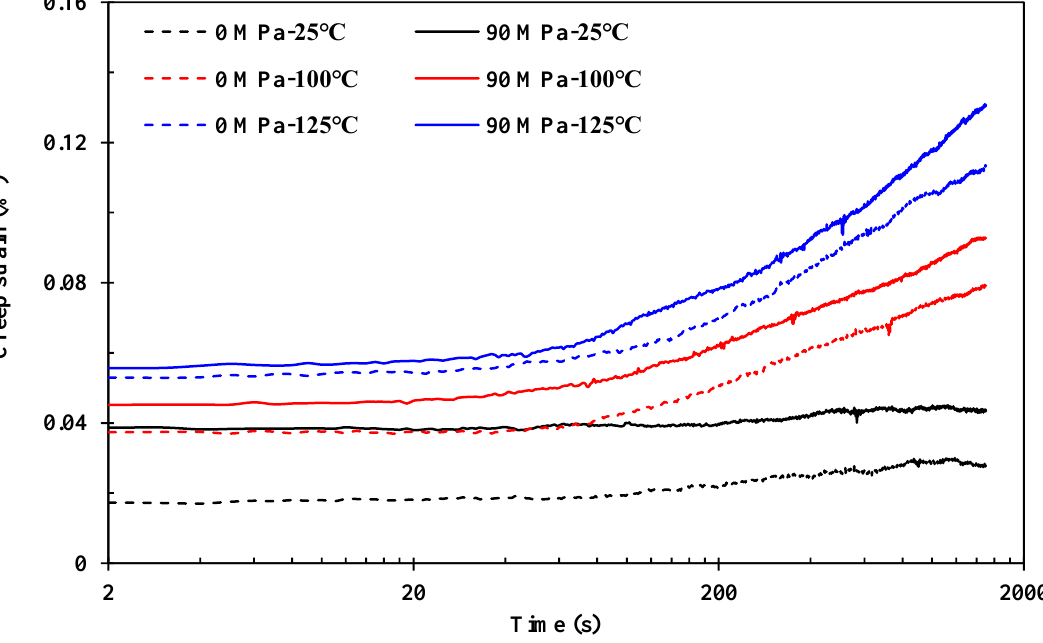
Figure 10. Effects of fibre prestressing level on the viscoelastic creep performance at 25, 100, and 125 °C (below T g ) in logarithmic scale, compared with the non-prestressed control samples.